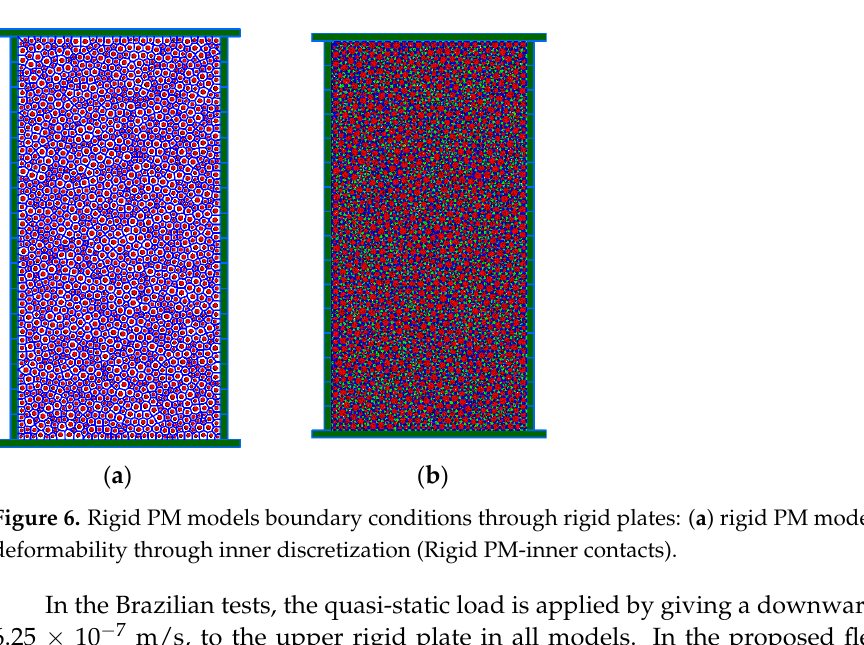
deformability through inner discretization (Rigid PM-inner contacts).